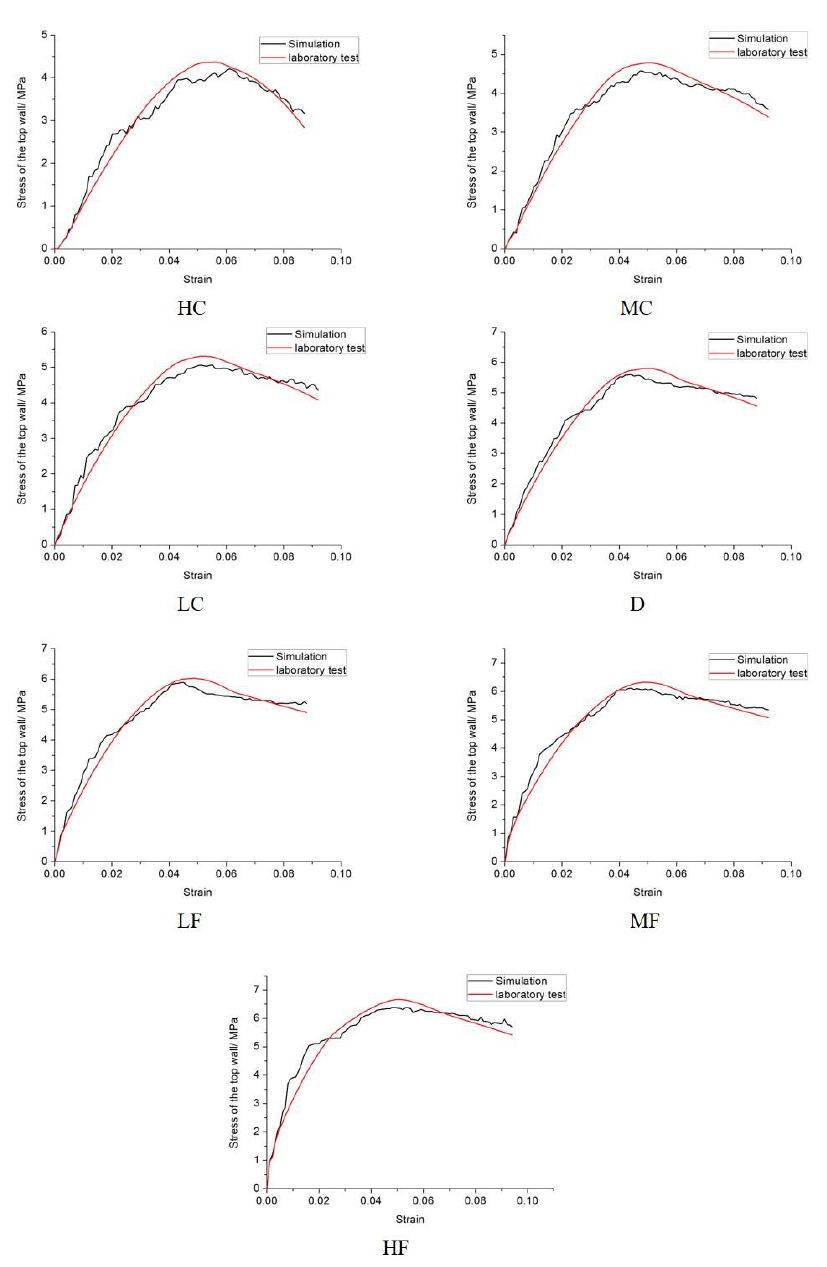
Figure 9. The stress-strain curves of the asphalt mixture.